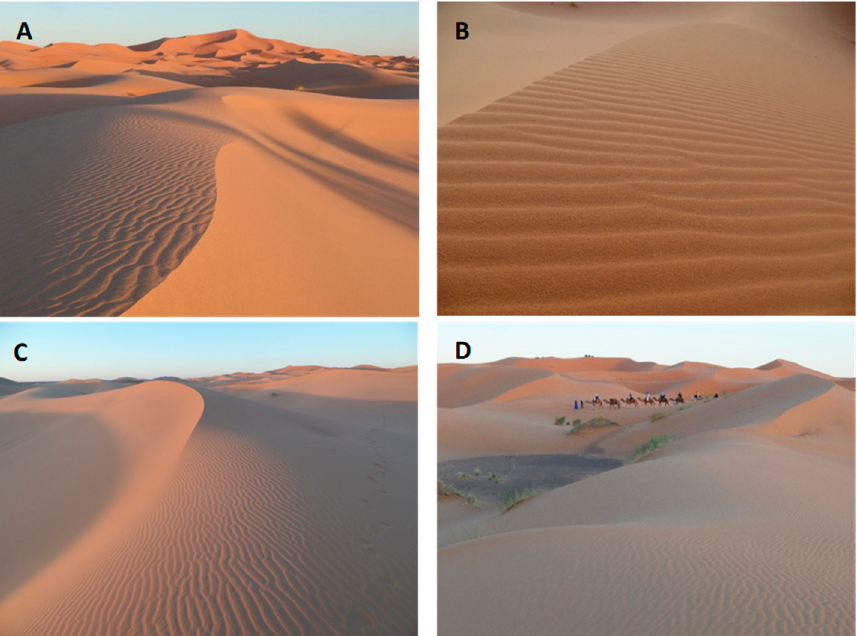
Figure 1. The locations of coastal sand dunes [28] and deserts at a global scale [29], and the locations of Figures 2–4 (bold).